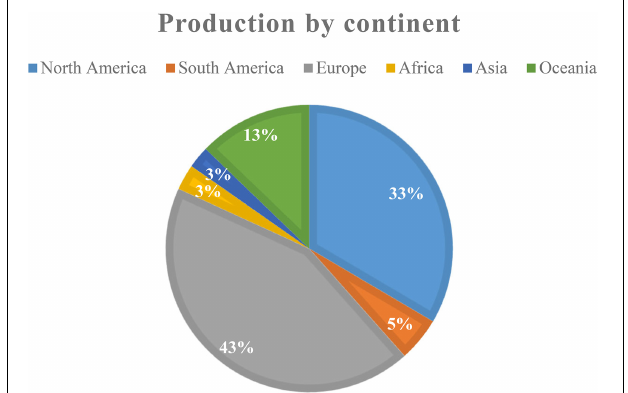
FIGURE 4 | Scientific production by continent (by number of articles; prepared by the authors).